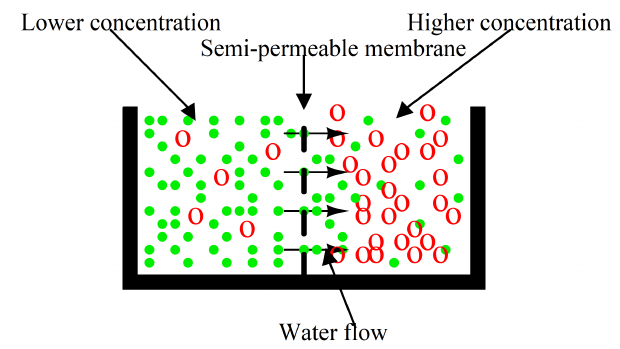
Figure 1. Water transportation across a semi-permeable